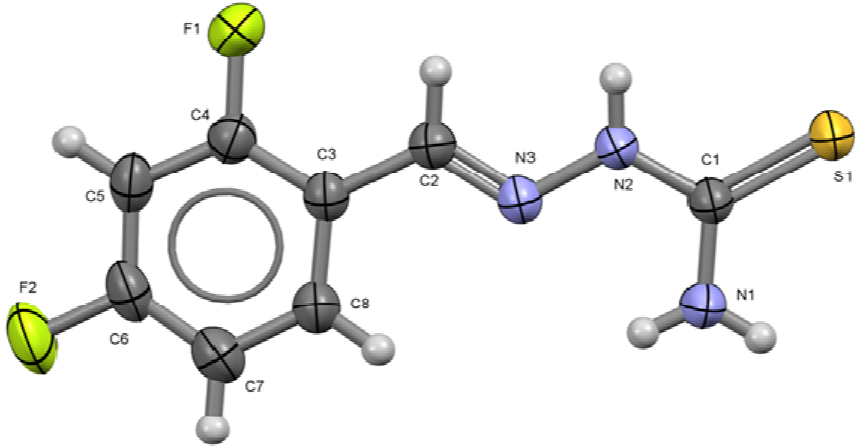
H F -CH=N-NH-C(S)NH ( 1 ). Thermal ellipsoids are 6 3 2 2